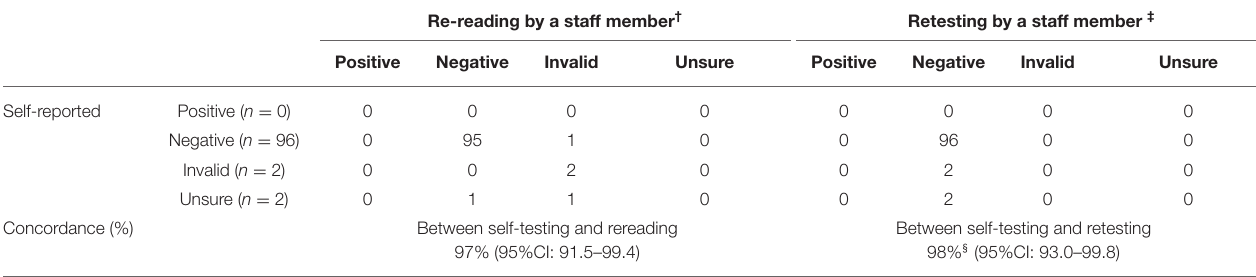
TABLE 3 | Assessment of inter-reader and inter-operator concordance among MSM, an observational study in China, 2019. Re-reading by a staff member †